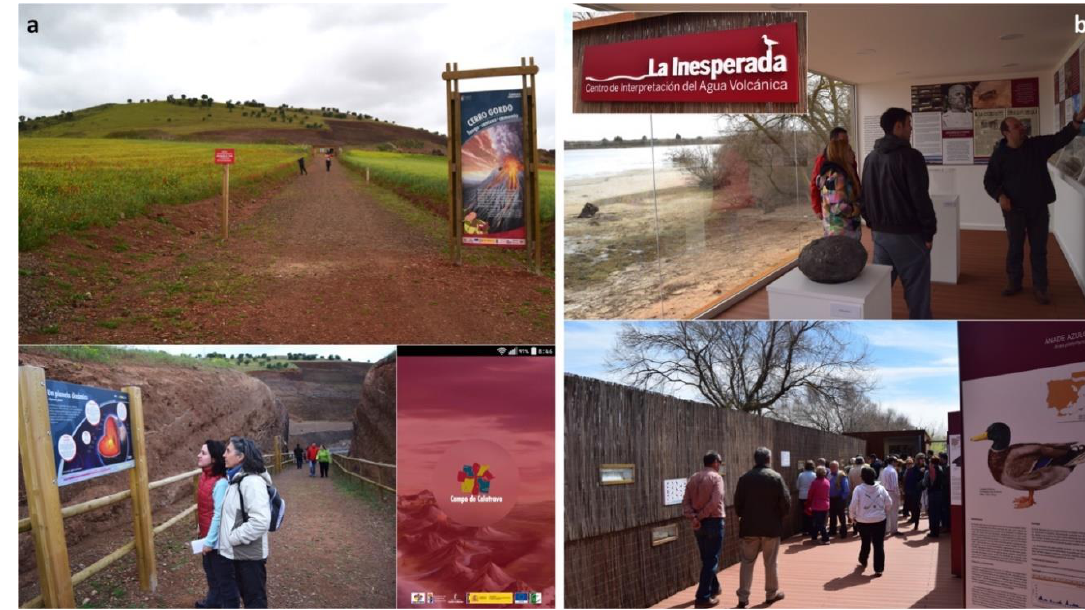
Figure 16. ( a ) Some images of the Centro de Interpretación de Cerro Gordo (Granátula de Calatrava); ( b ) some images of Centro de Interpretación del Agua Volcánica La Inesperada (Pozuelo de Calatrava).